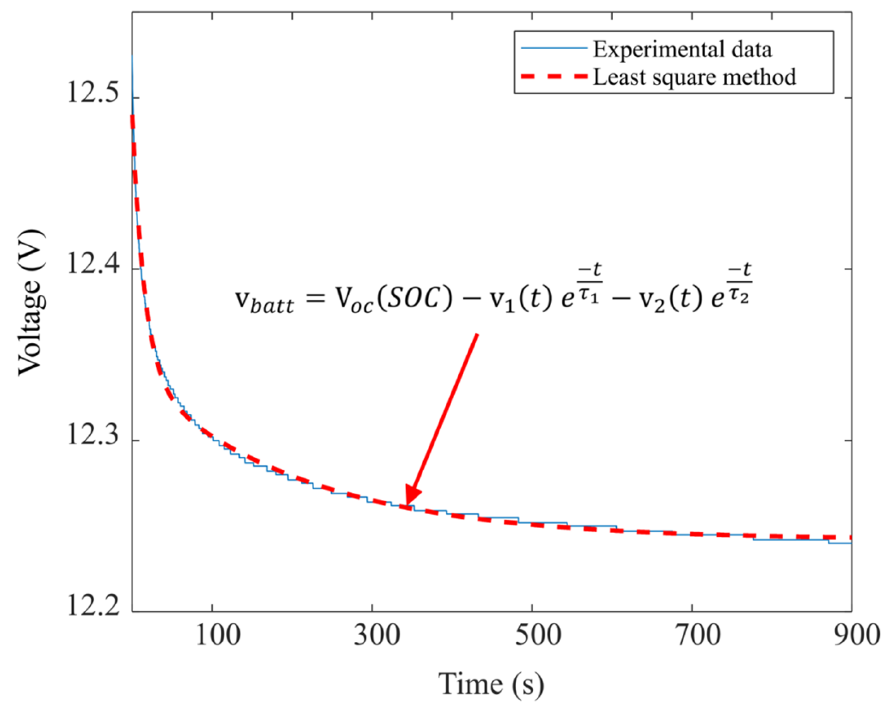
Figure 9. Voltage relaxation curve characterization using least square method.